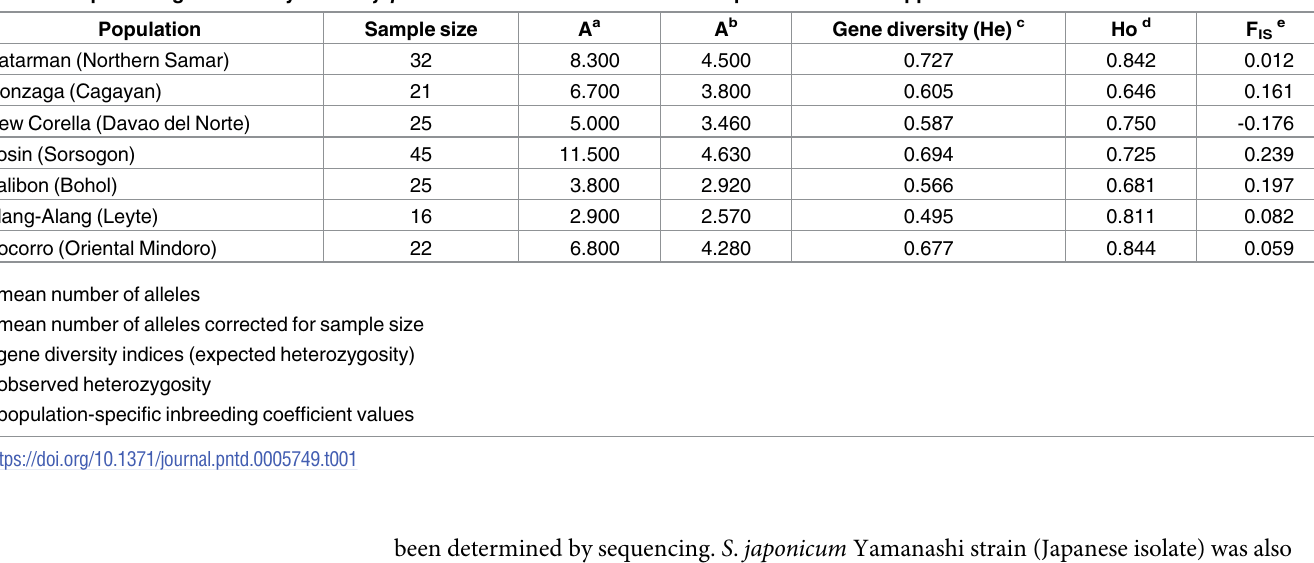
Table 1. Population genetic analysis of S . japonicum from seven endemic municipalities in the